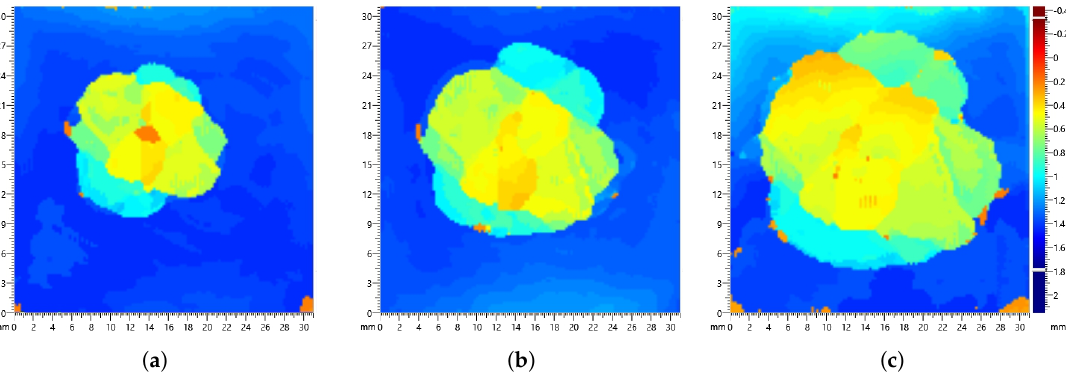
Figure 17. C-scan of BVID on the DuraAct CFRP panel for each impact event, with increasing energy energy ( a ) 4.8 J, ( b ) 6.41 J and ( c ) 7.84